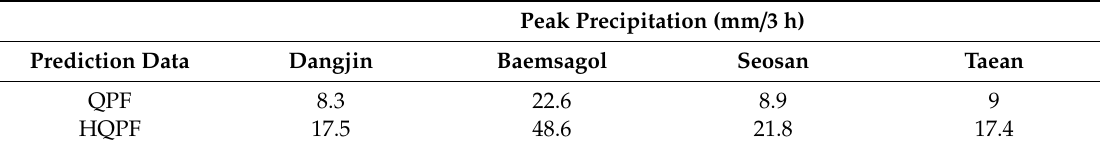
Table 9. Peak precipitation (mm / 3 h).